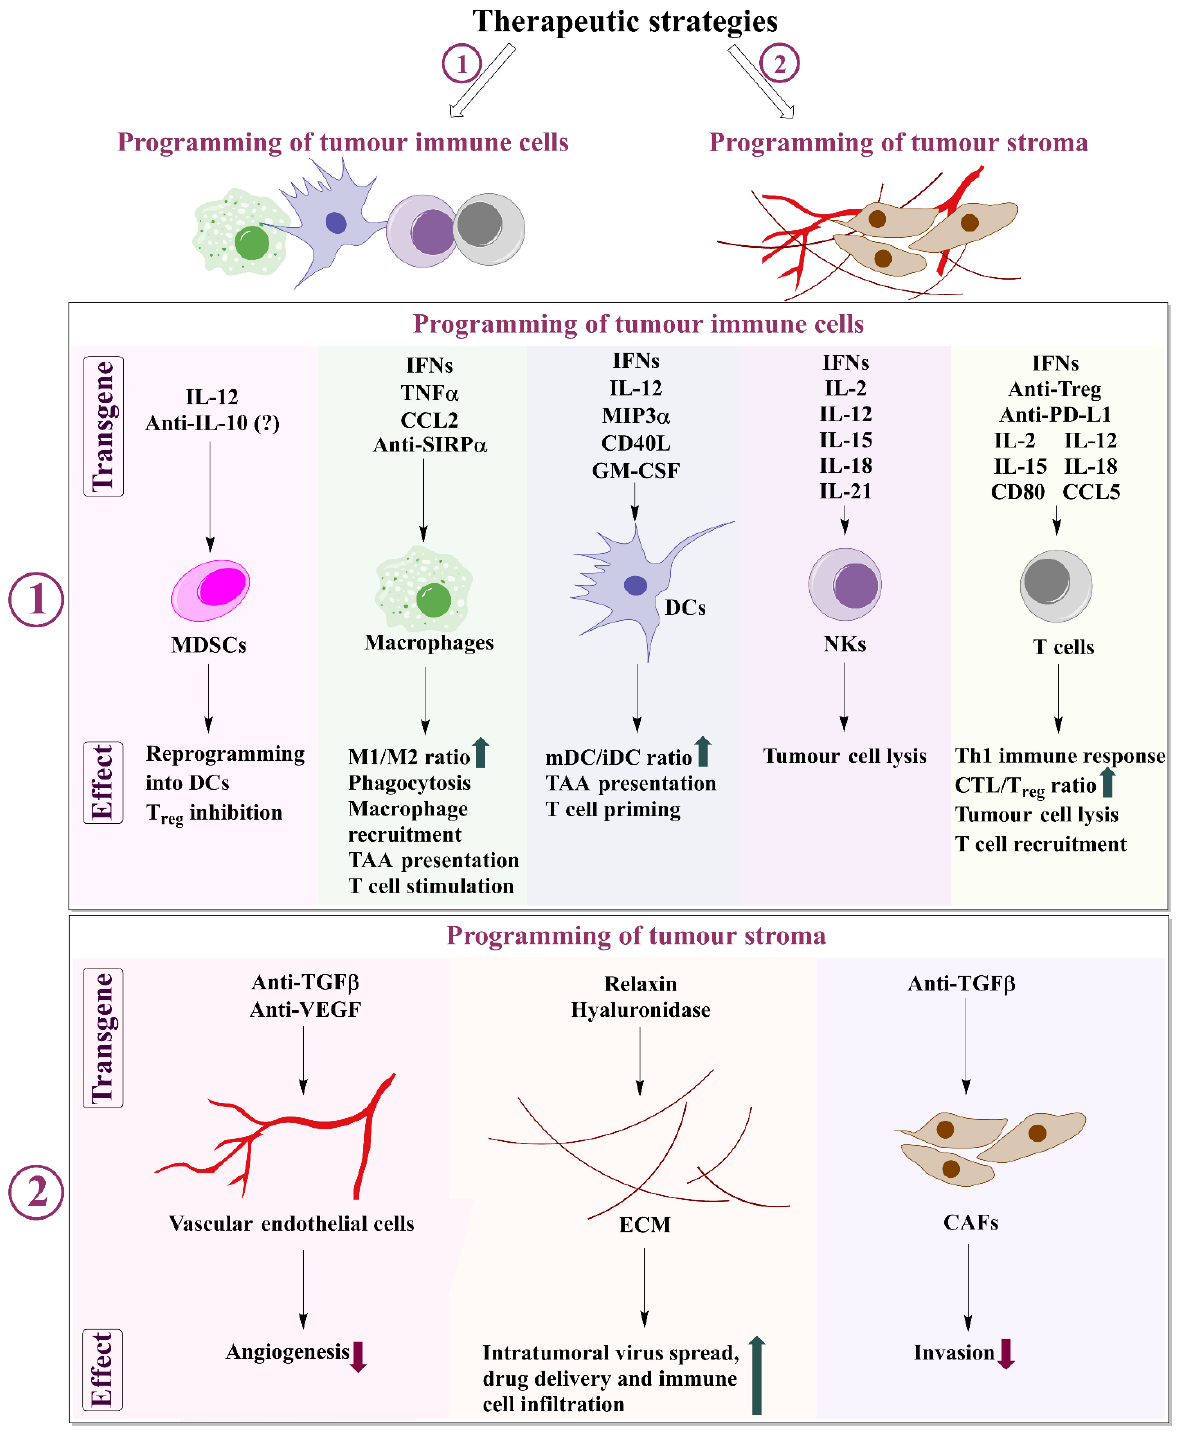
Figure 3. Cancer therapy strategies for programming tumour immune cells (1) and tumour stroma (2). Transgenes expressed by viral vectors promote a “hot” immunostimulating tumour microenviron- ment and support anti-tumour immunity (effects). Green arrows represent upregulation of the effect, while red arrows – downregulation. M1—classically activated macrophages, M2—alternatively acti- vated macrophages, CAA—cancer-associated antigens, Th1—type I T helper cell, Treg—regulatory T cell, CTL—cytotoxic T lymphocyte, NKs—natural killer cells, MDSCs—myeloid-derived suppres- sor cells, iDC—immature dendritic cell, mDC—mature dendritic cell, DC—dendritic cells, ECM— extracellular matrix, CAFs—cancer-associated